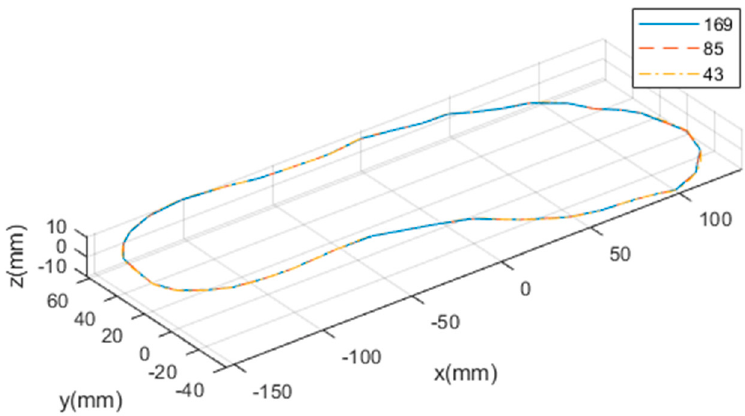
Figure 20. Paths planned using 169, 85, and 43 points.